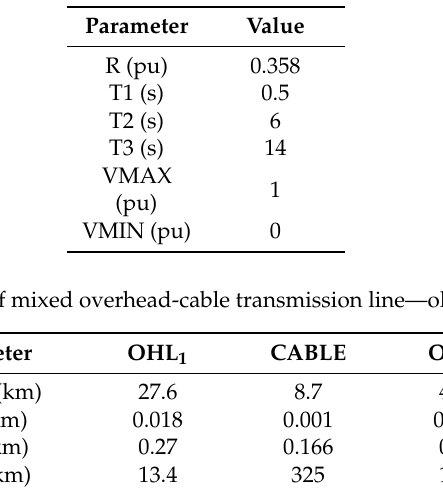
Table A9. Parameters of turbine type TGOV1.